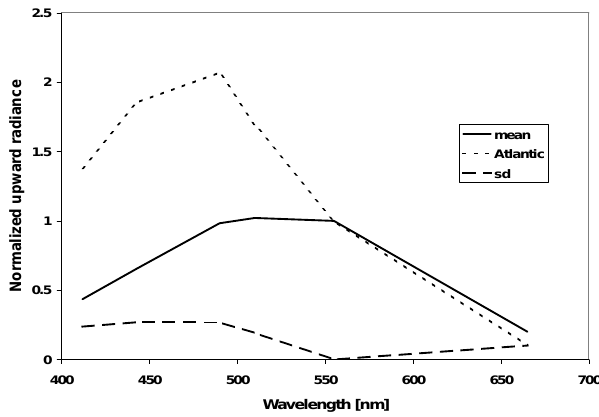
Fig. 2. Mean value of the upward radiance spectra just beneath the surface, normalised at 555nm and based on 48 stations, and the standard deviation of the normalised spectra. For comparison a sta- tion of typical Atlantic water is